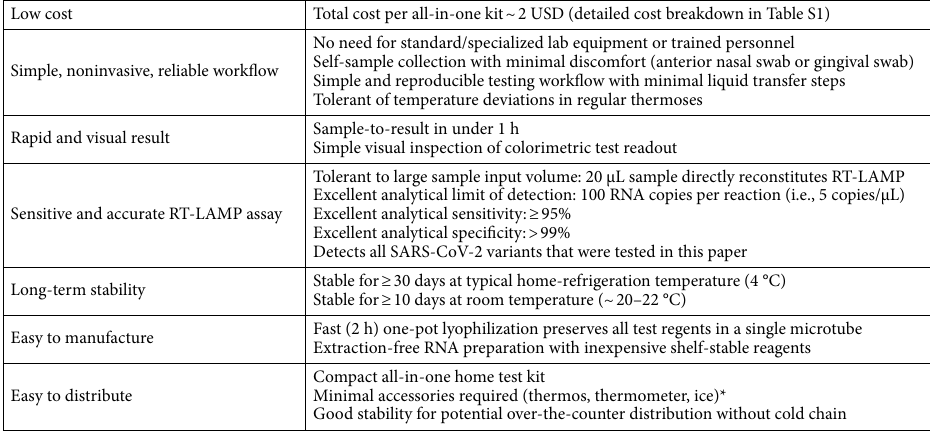
Table 3. Features and advantages of the COVID-19 molecular home test kit. *The thermos/thermometer can be replaced by other low-cost solutions depending on use case.